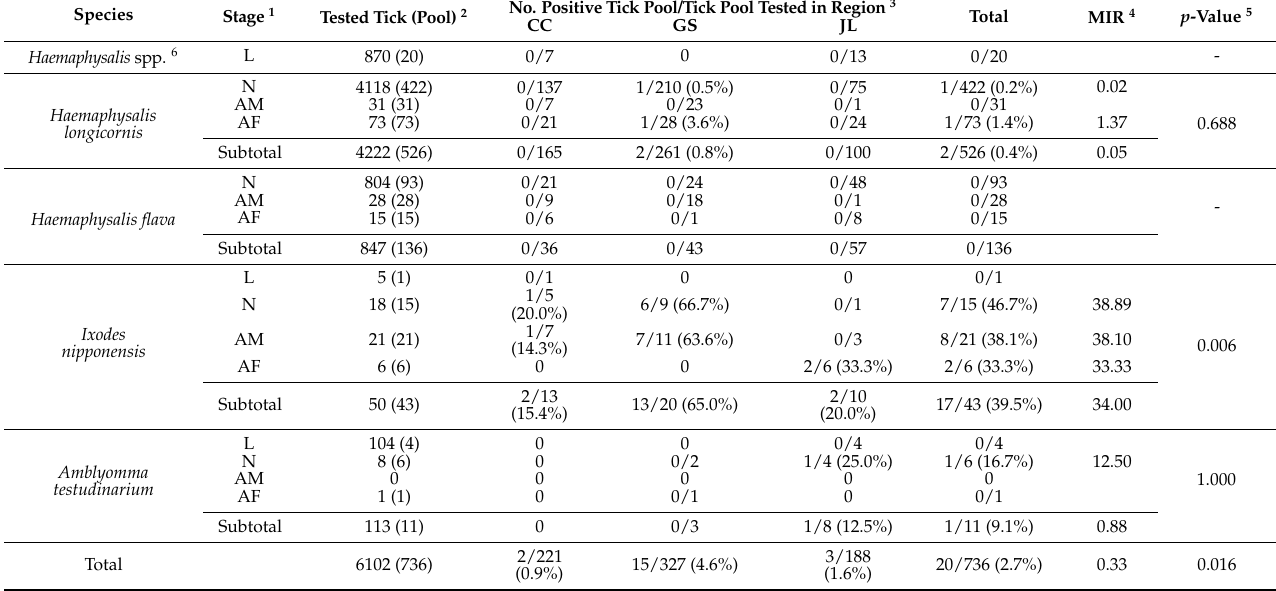
Table 2. Prevalence of Borrelia in ticks collected in the central and southern regions of Korea, concerning tick species, developmental stage, and